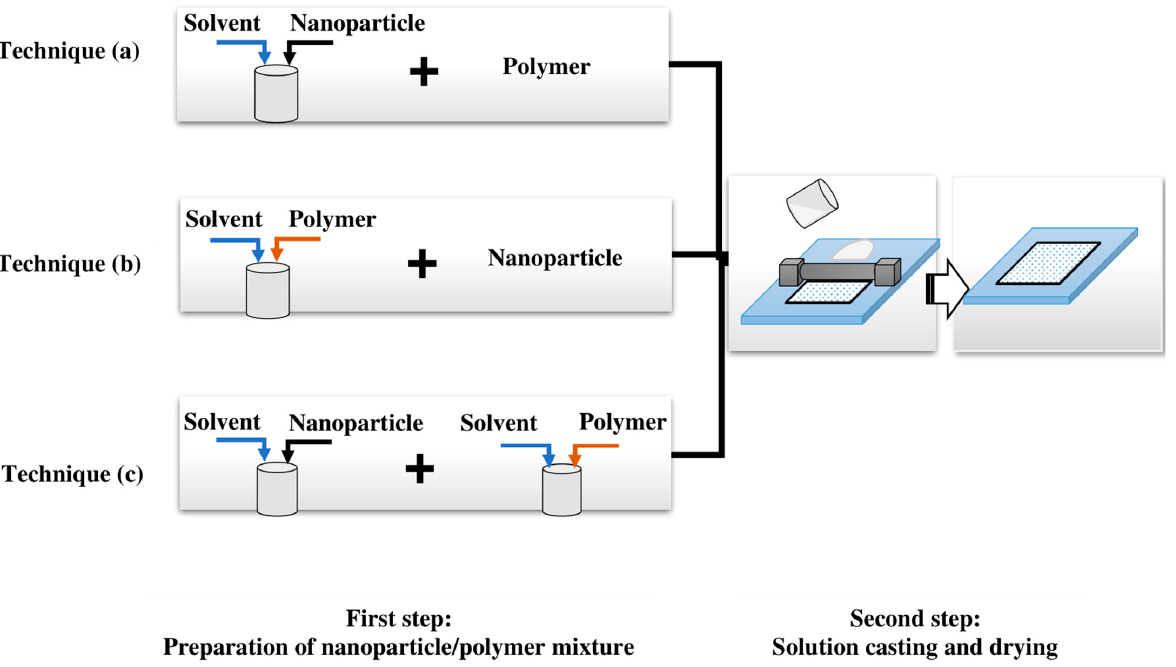
Figure 4. Schematic representation of steps involved in the preparation of nanocomposite PV membranes. Technique ( a ): Dispersion of nanoparticles into the solvent and addition of polymer; Technique ( b ): Polymer dissolution in the solvent and the addition of nanoparticles; Technique ( c ): Dispersion of nanoparticles and mixing it with a solution of the polymer in the